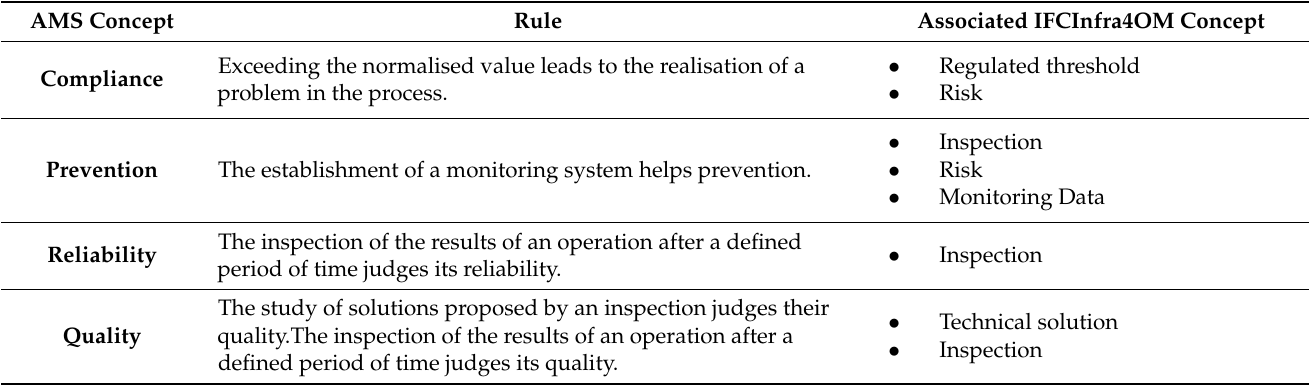
Table 4. Integrating O&M Rules into the IFCInfra4OM Ontology.